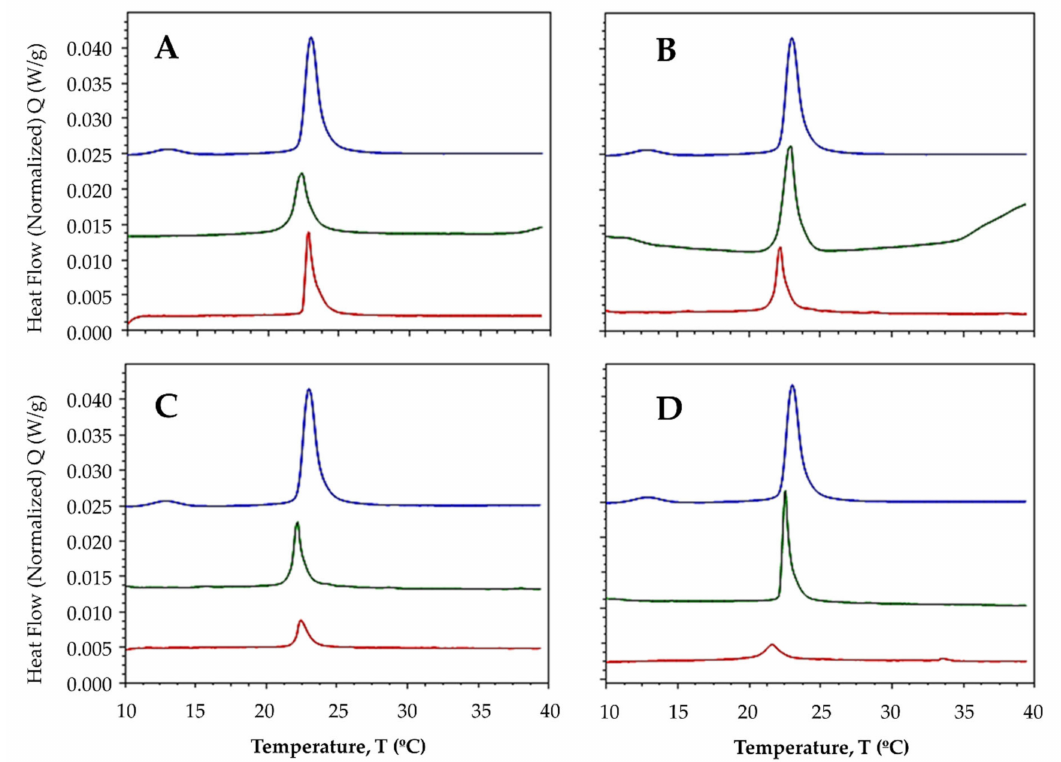
Figure 3. Thermotropic profile of MLVs made up of DMPC before ( ---- ) and after adding the ligand ( ---- ) and the La complex ( ---- ) in a 1:50 compound-lipid molar ratio. ( A ) L1; ( B ) L2; ( C ) L3; and ( D )